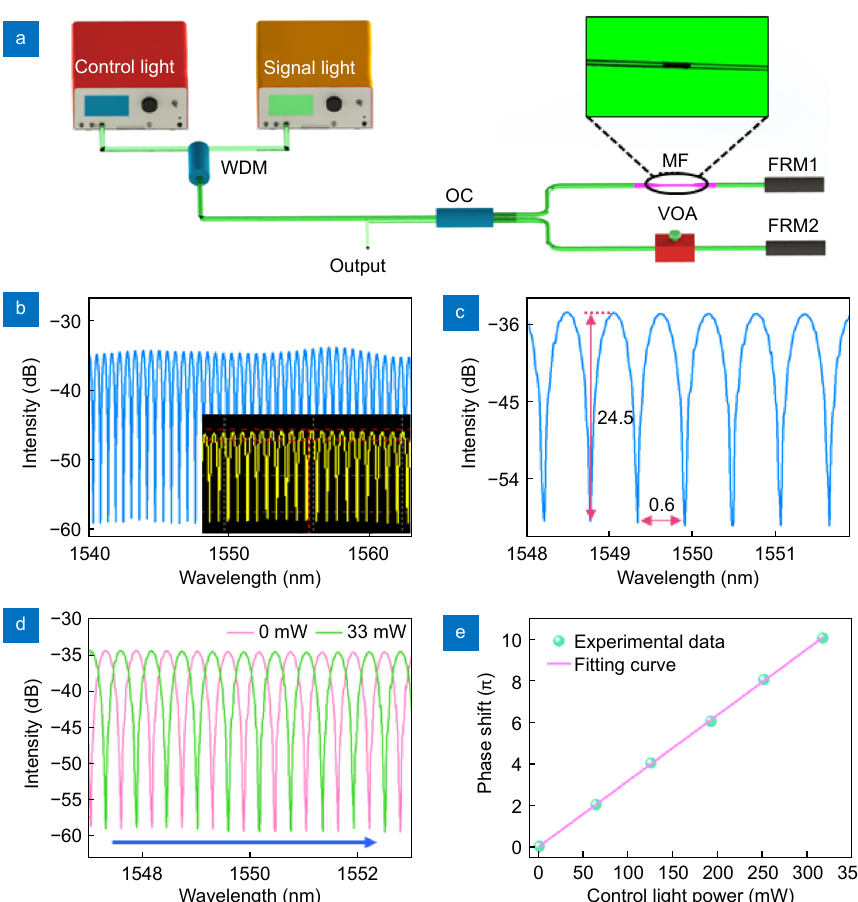
Fig. 3 | ( a ) The experimental diagram of the all-optical modulator. ( b , c ) Interferometric spectrum of signal light. ( d ) Interferometric spectra at the control light power of 0 mW and 33 mW. ( e ) Phase shift versus the control light power.